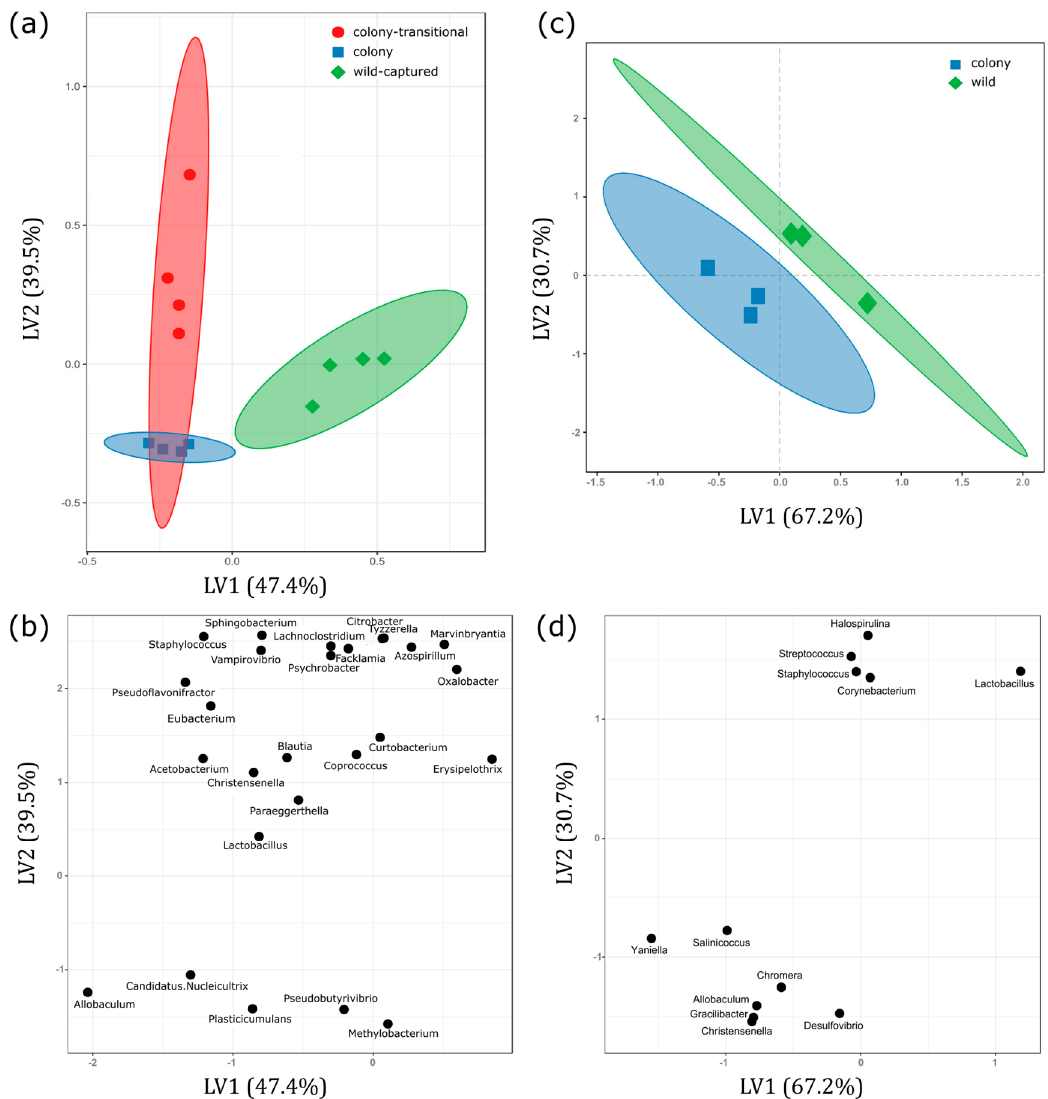
Figure 2. Partial least squares-discriminant analysis (PLS-DA) reveals discriminating characteristics of genus-level microbiota depending on diet group. Figures display ( a ) scores plot of fecal samples ( b ) PLS-DA loadings scatterplot of fecal samples ( c ) scores plot of foregut samples and ( d ) PLS-DA loadings scatterplot of foregut samples. Scores plots cluster based on group assignment. Each symbol represents an individual vole. Shaded ellipses indicate 95% confidence intervals. PLS-DA loadings scatterplots show the genera that influence how groups are being pulled apart. PLS-DA loadings are limited to VIP scores >2.